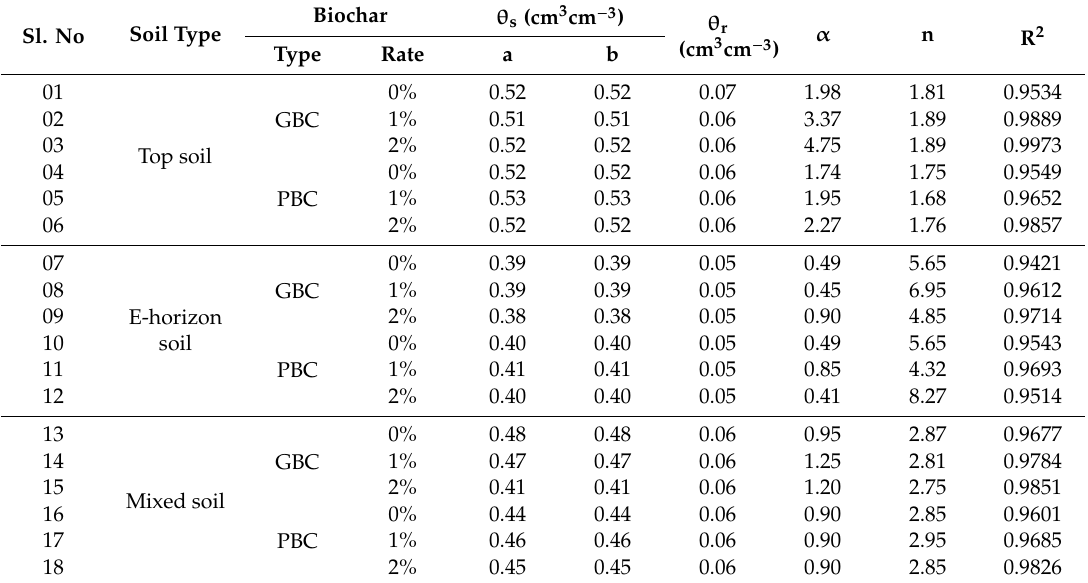
Table 3. Fitted and measured values of the saturated and residual water content and parameters of the fitted values of the soil water retention